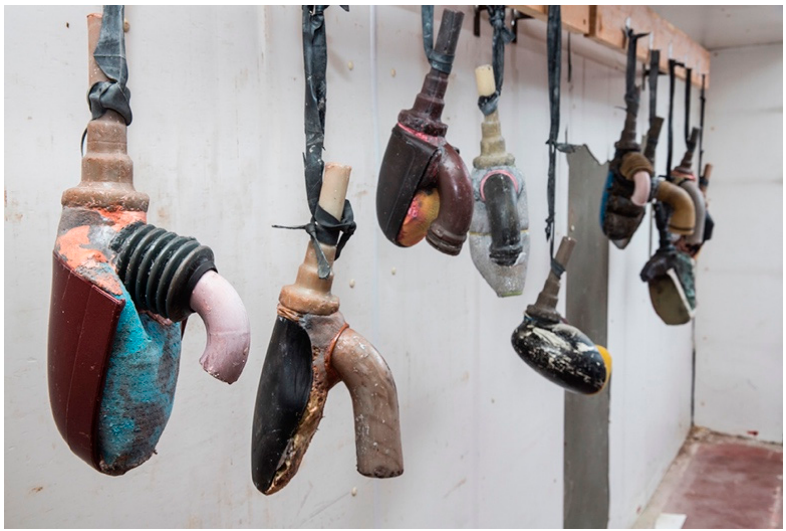
Figure 6. Matthias. 2016. Drill Bits , featured in S-O-T Body Repairs exhibition.